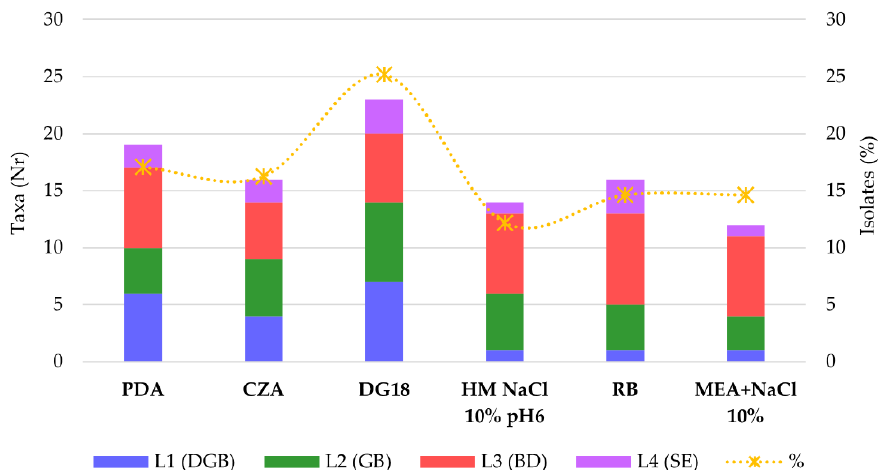
Figure 10. Number of different taxa and % of total isolates (same or different taxa) retrieved from each culture media.